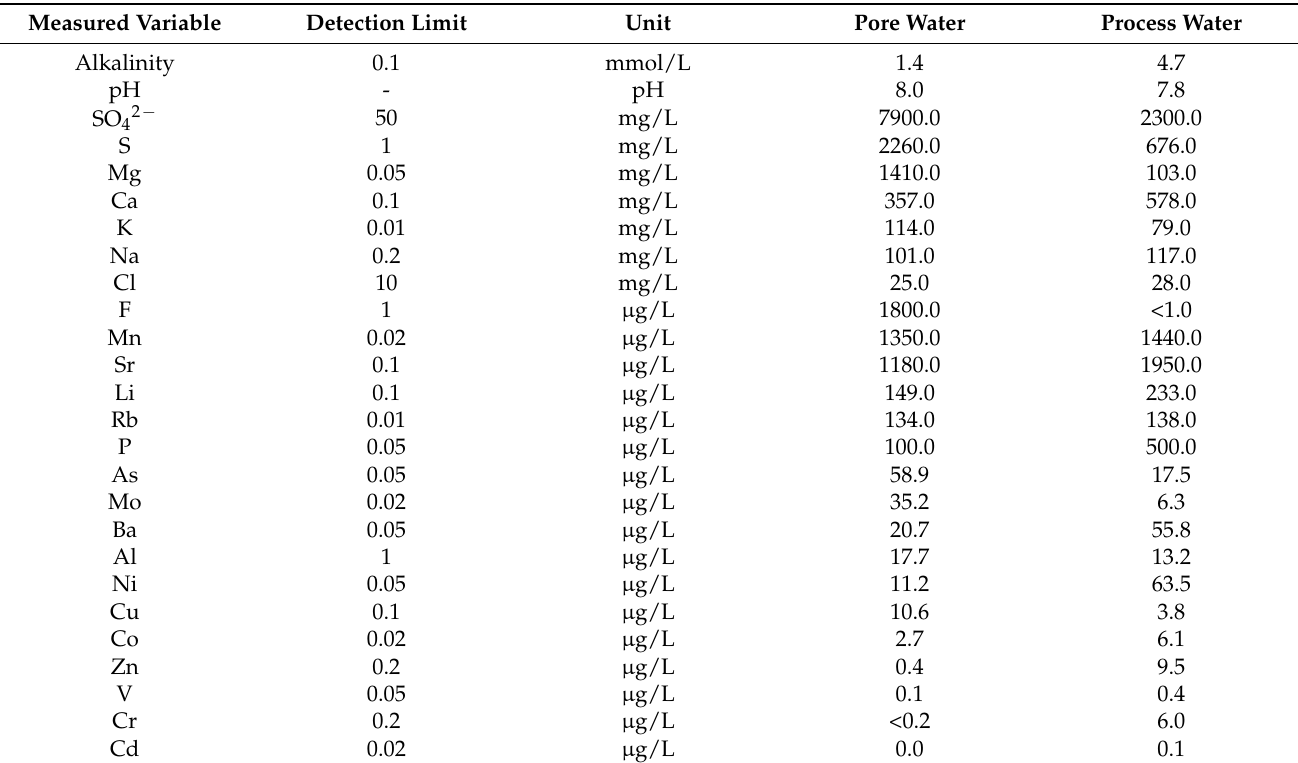
Table 2. Properties and chemical contents of process water and tailings pore waters used in the preparation of the CPB mixtures.